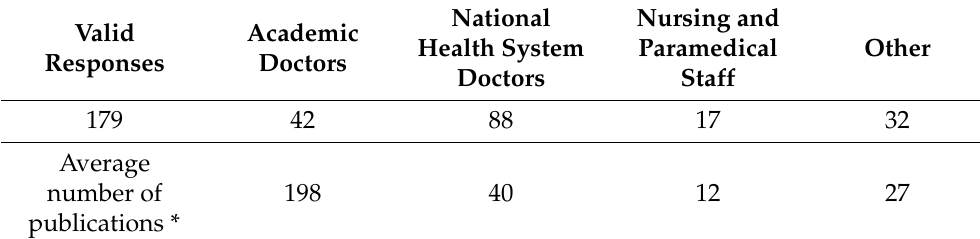
Table 1. Publication history information based on Google Scholar results per participants’